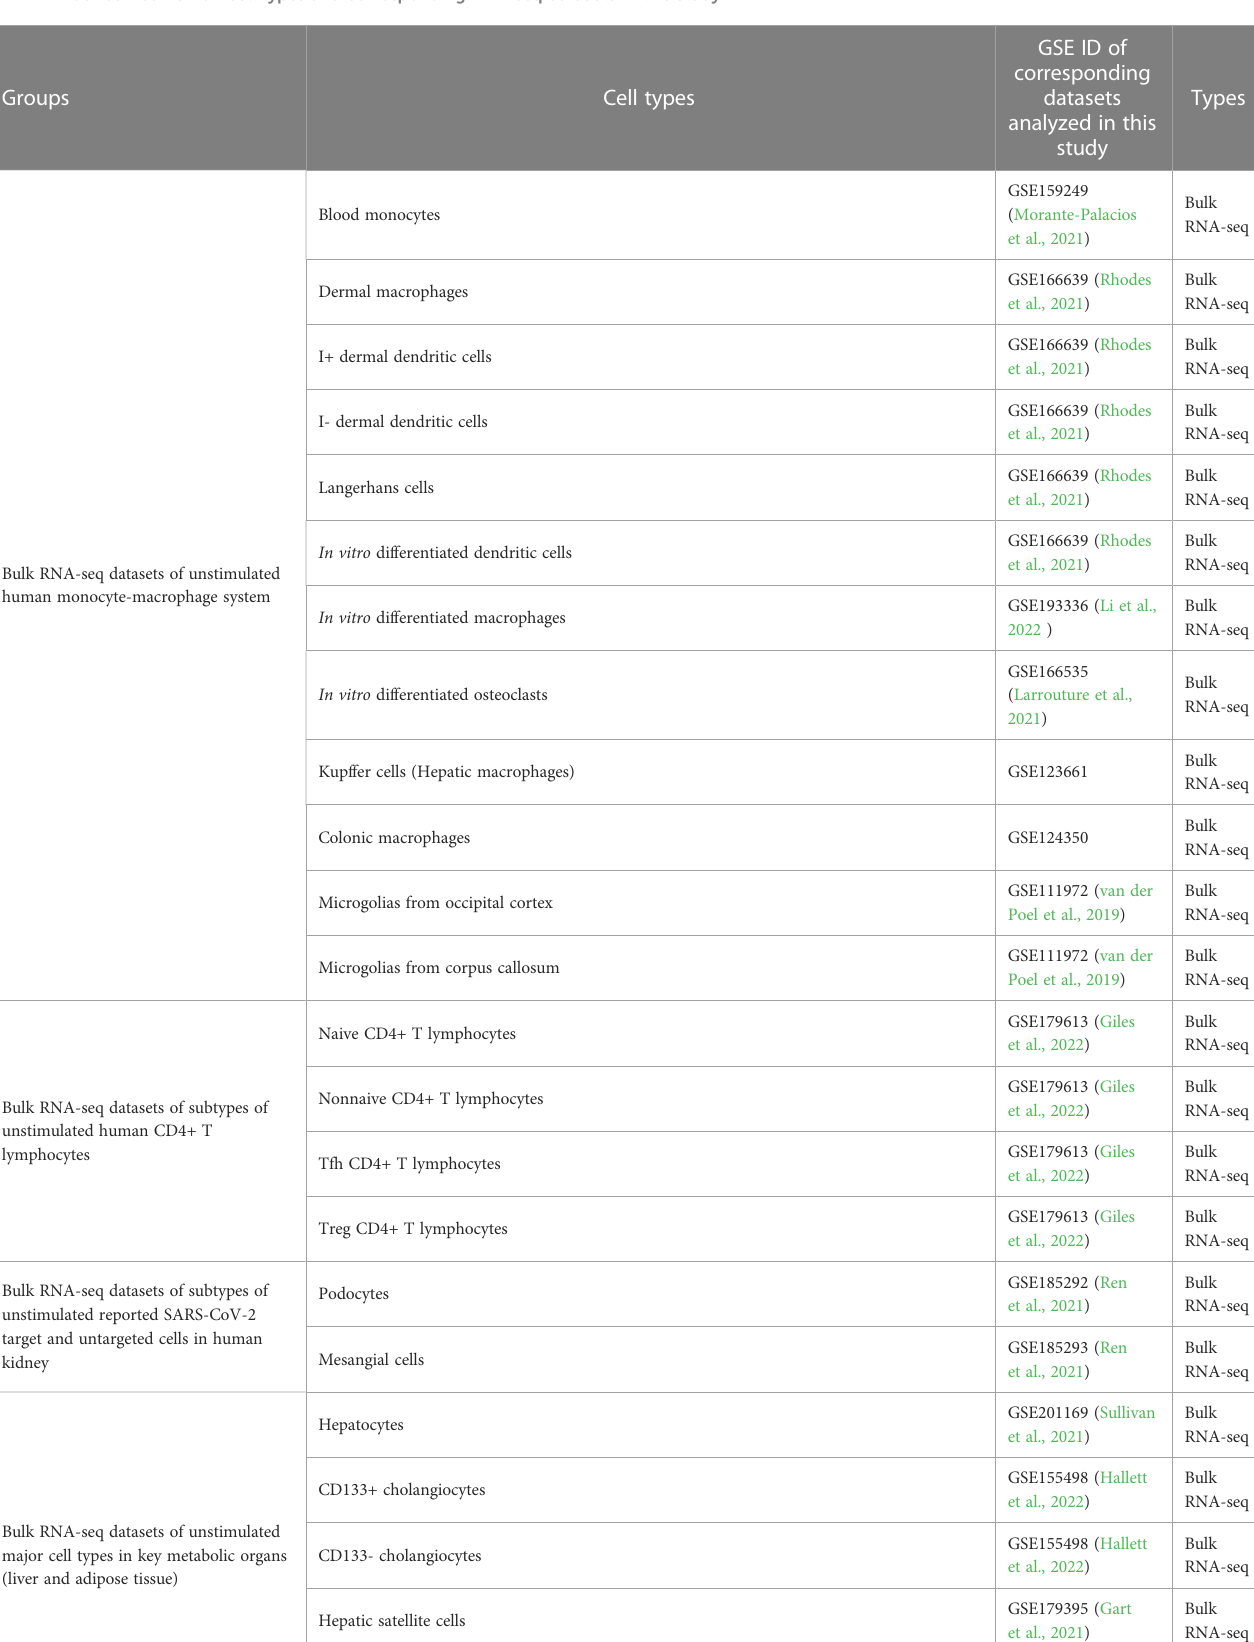
TABLE 1 Concerned human cell types and corresponding RNA-seq datasets in this